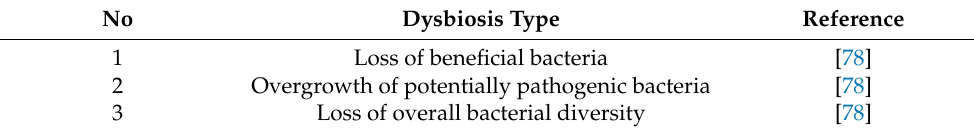
Table 1. Types of dysbiosis.